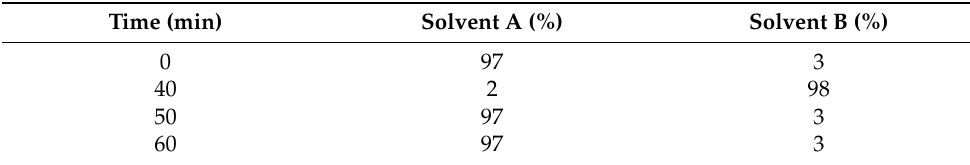
Table 9. Gradient for semi-preparative HPLC